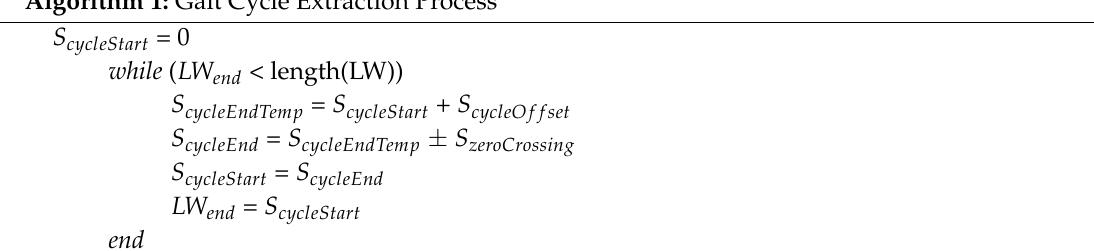
Algorithm 1: Gait Cycle Extraction